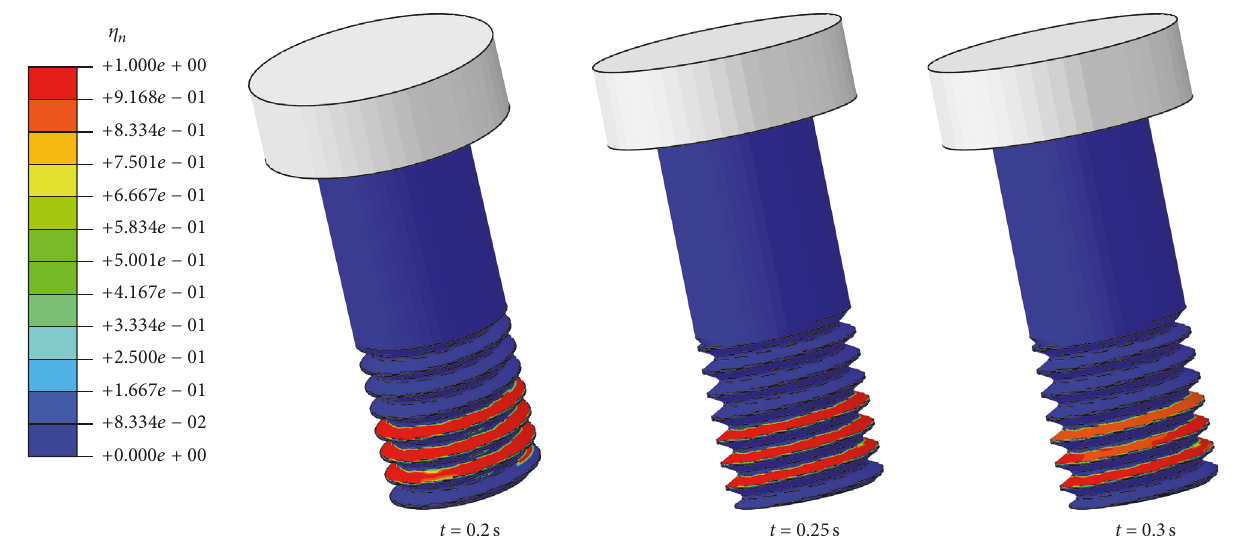
Figure 26: The slip state contours between thread